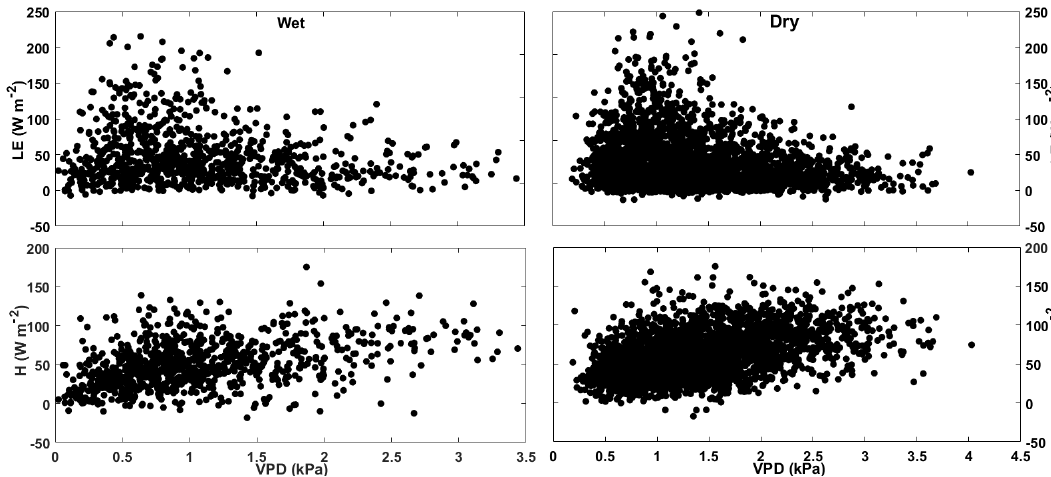
Figure 8. Relationship between the fluxes and VPD under wet and dry conditions.